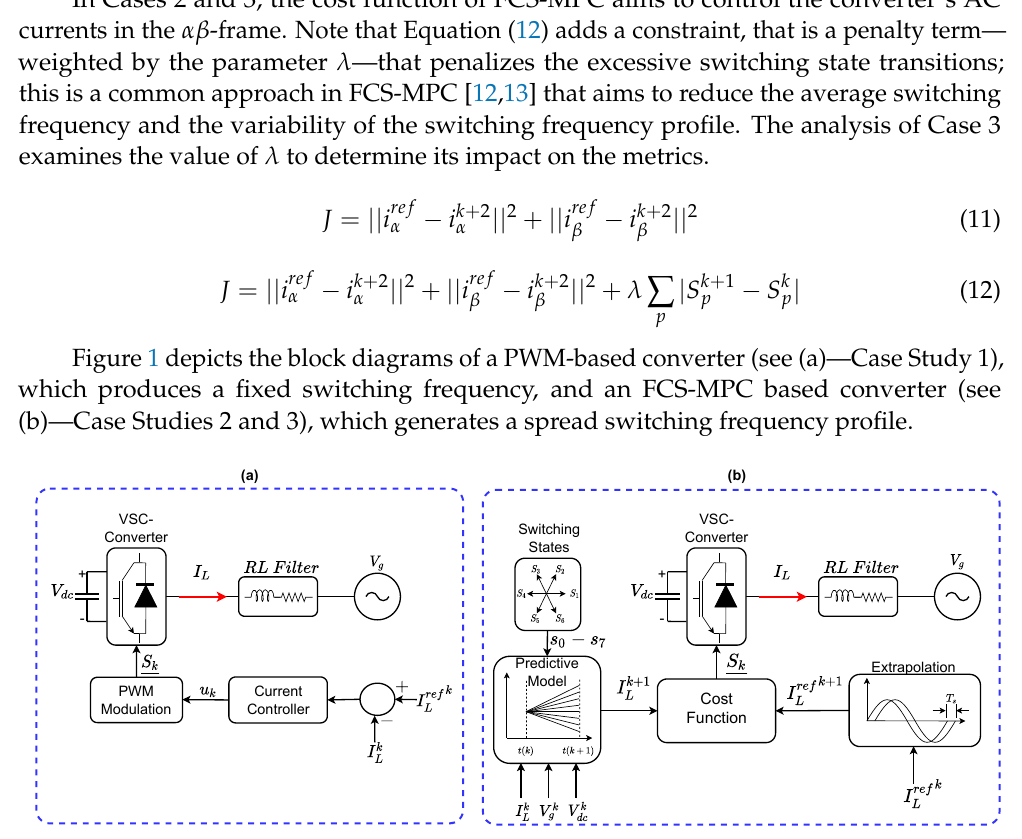
Figure 1. PWM-based converter connected to the grid with a classical linear AC current control ( a ); FCS-MPC-based current-controlled converter connected to the grid ( b